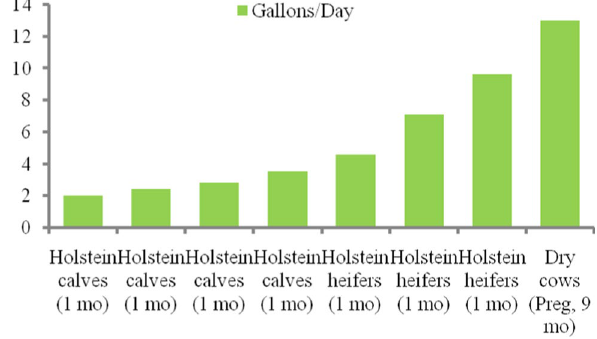
Fig. 7 Normal water intake of dairy cattle. Adopted from Adams and Sharpe (1914)